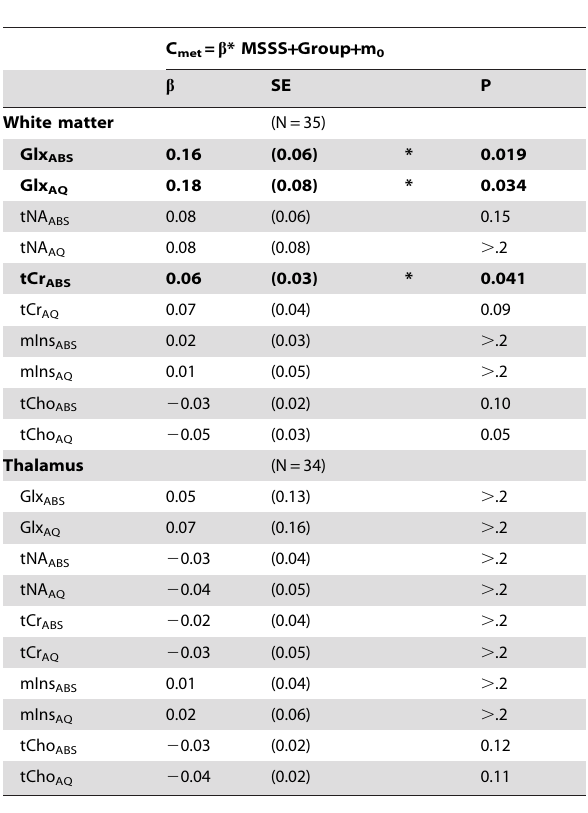
Table 4. Association between metabolite concentration and MS Severity Score